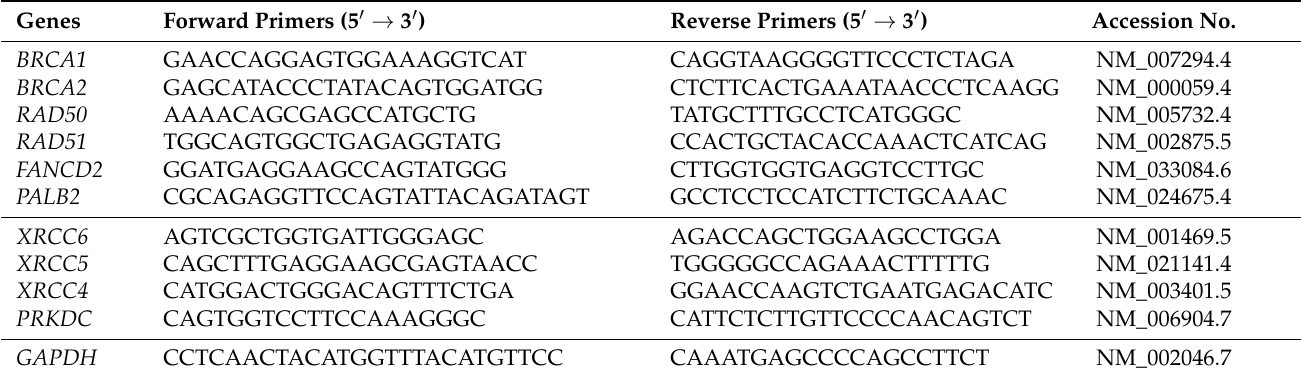
Table 1. Basic information for DNA repair by HR and NHEJ